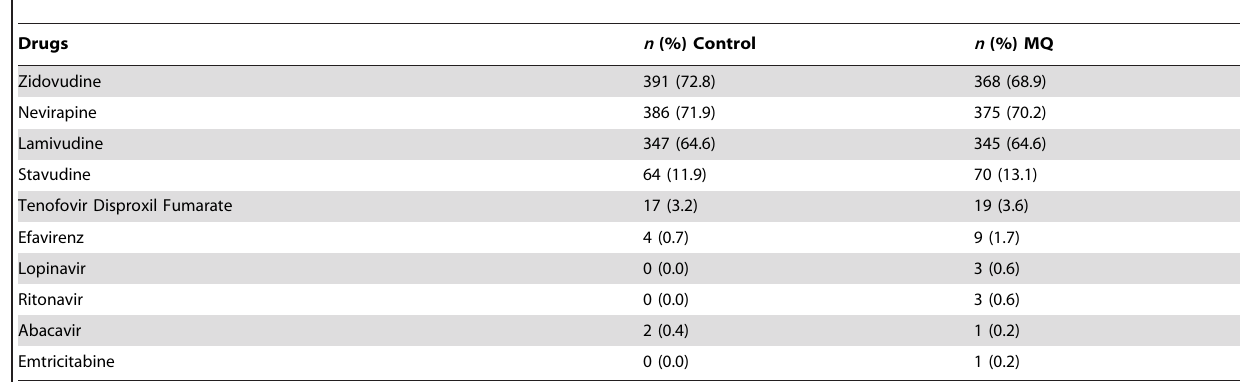
Table 11. Concomitant antiretroviral medication by treatment group (ITT cohort).